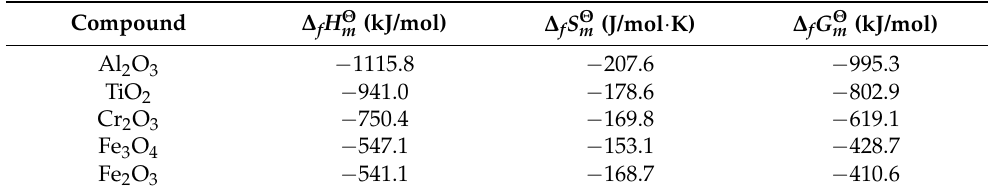
Table 2. Values of ∆ f G Θ m , ∆ f H Θ m , and ∆ f S Θ m in the Gibbs formation energy expressions ( T = 773.15 K). Compound ∆ f H Θ m